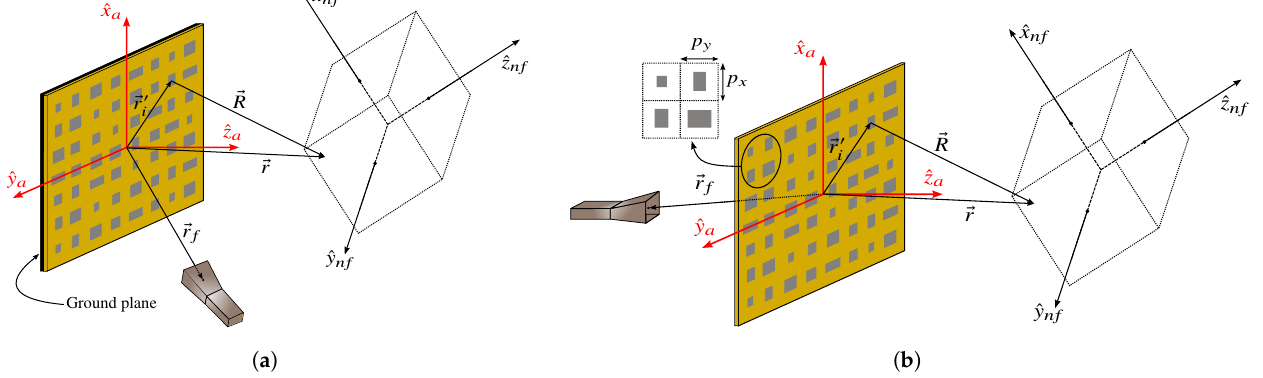
Figure 1. Sketch of the ( a ) reflectarray and ( b ) transmitarray scenarios. The goal is to obtain the near field radiated by the arrays in a volume in front of the antenna. The analysis of the arrays is carried out in the array coordinate system (ACS) defined by ( ˆ x a , ˆ y a , ˆ z a ) , while the radiated field will be obtained in the near field coordinate system (NFCS) defined by ( ˆ x nf , ˆ y nf , ˆ z nf ) . The transformation between ACS and NFCS may be consulted in Appendix